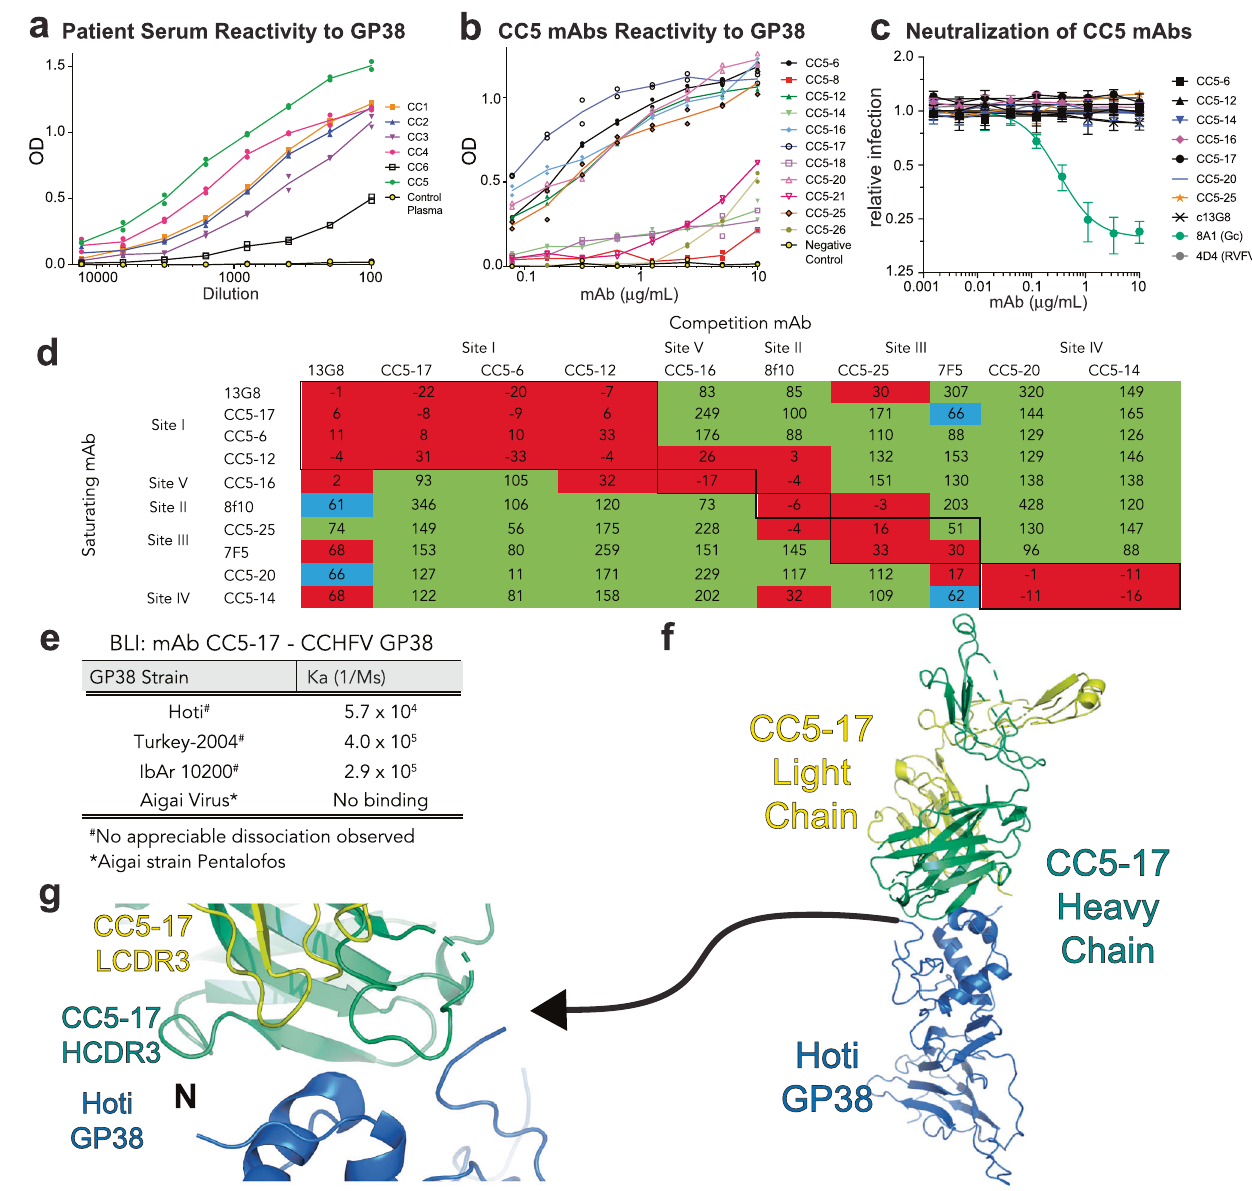
Fig. 2 | Generation of human-derived anti-GP38 mAb s . a Six CCHF survivors in Trabzon (Turkey) were recruited, and their plasma were collected to determine their ELISA titers against GP38 Turkey2004. b Patient CC5 was selected, and its plasma was used to mine 11 mAbs which were then retested against GP38. ELISA experimentswereperformedinduplicate( n =2.) c Neutralizationpotentialofanti- GP38mAbs.FocireductionneutralizationassayswereperformedwithCCHFV-ZsG. These data represent one independent experiment out of 2.The average valuesof replicatewells( n =4)areplotted,anderrorbarsrepresenttheassociatedstandard